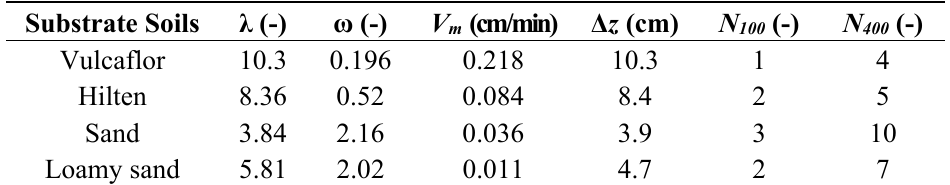
Table 4. Simulation parameters.